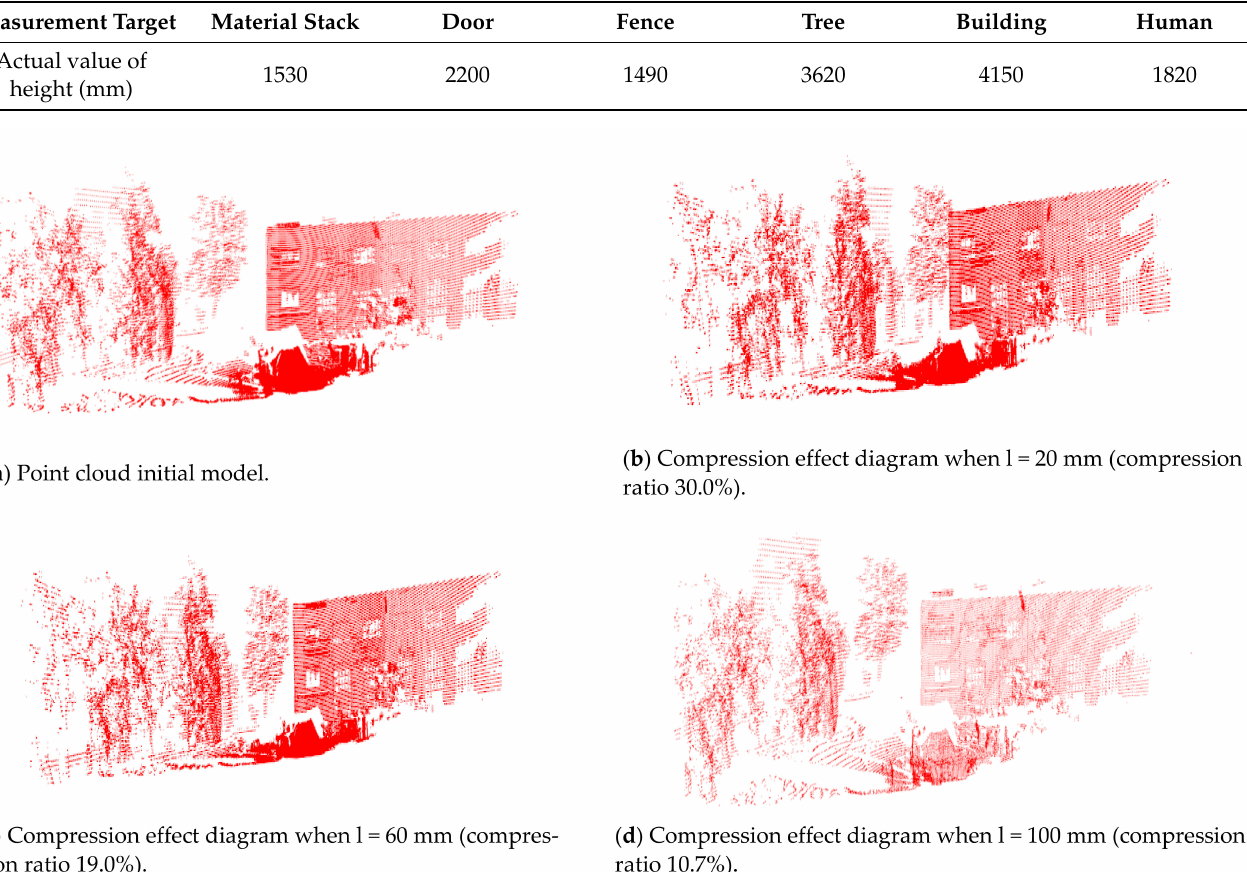
Figure 9. Compression effect of point cloud model under different side